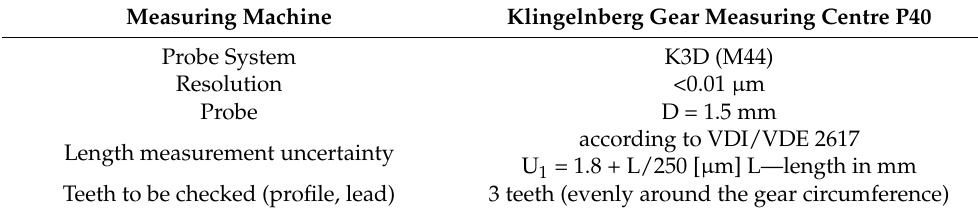
Table 4. Parameters used to measure the gears.